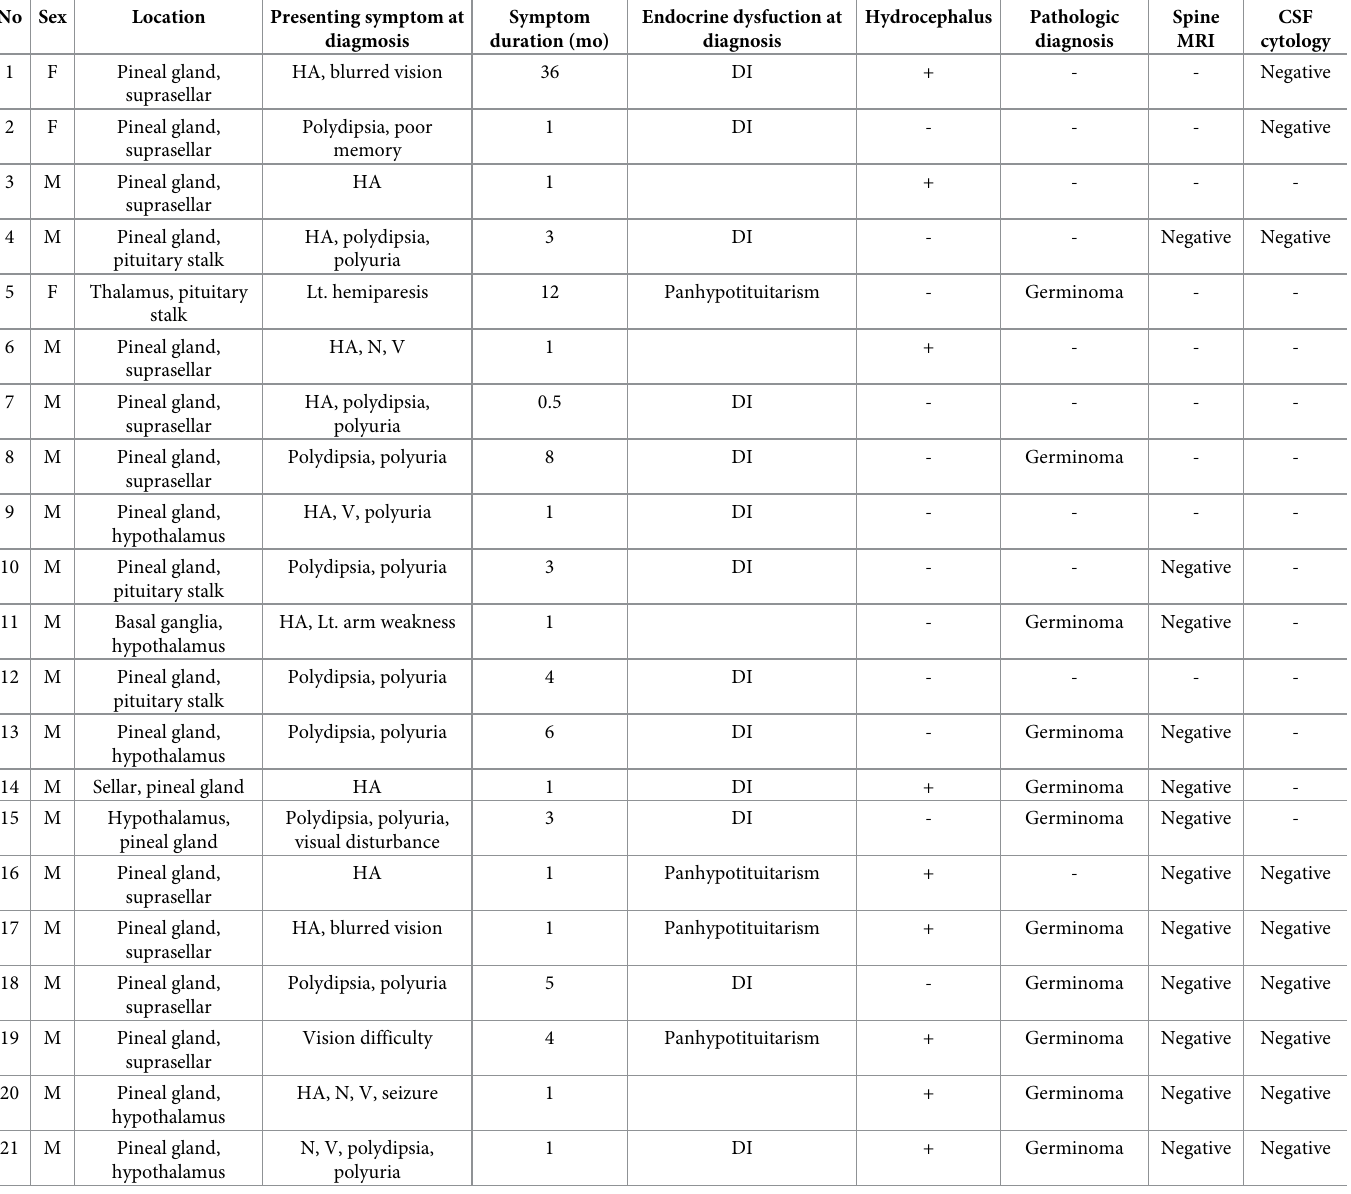
Table 1. Patient and tumor characteristics. Patient and tumor characteristics of 21